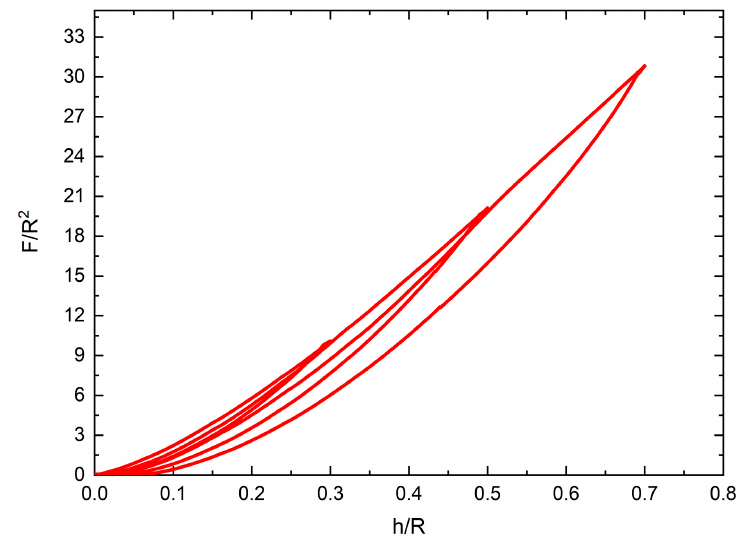
Figure 2. Test results for the unfilled polyurethanes (UFPUs) subjected to cyclic compressive loads.